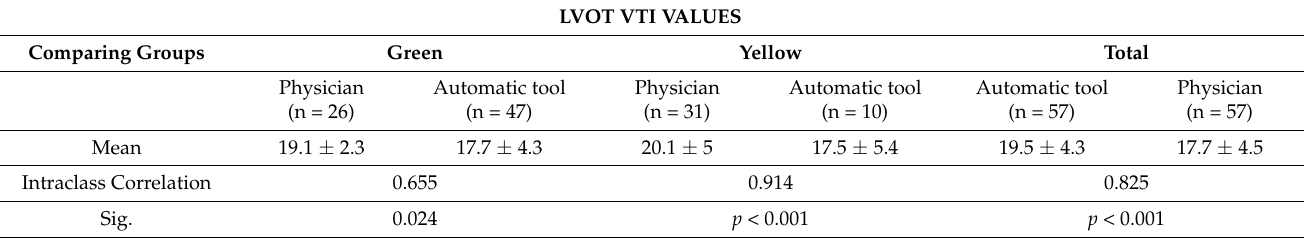
Table 4. VTI analysis—quality stratification and comparison between auto LVOT-VTI tool and manual assessment by POCUS